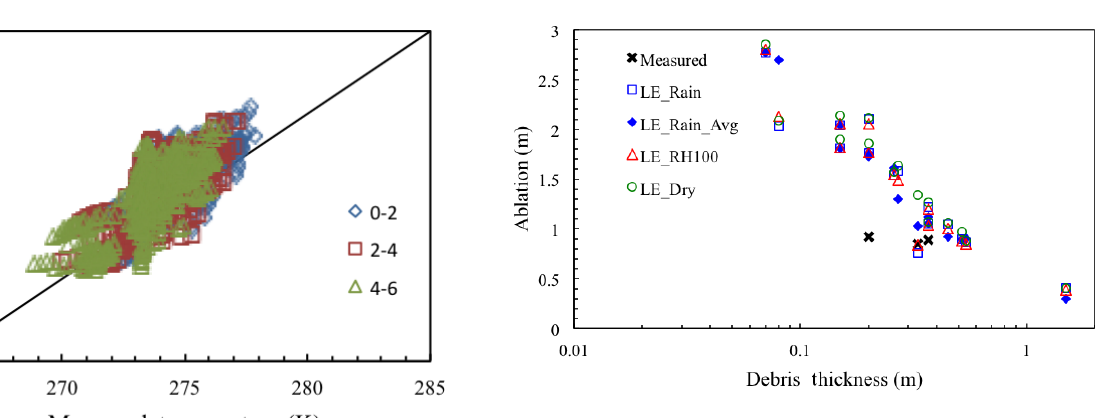
Figure 7. Modeled ablation with respect to debris thickness for all 15 sites from 18 May to 9 November 2014 for each of the three latent heat flux models, including the LE Rain model, with average values and the three measured stakes that did not exceed